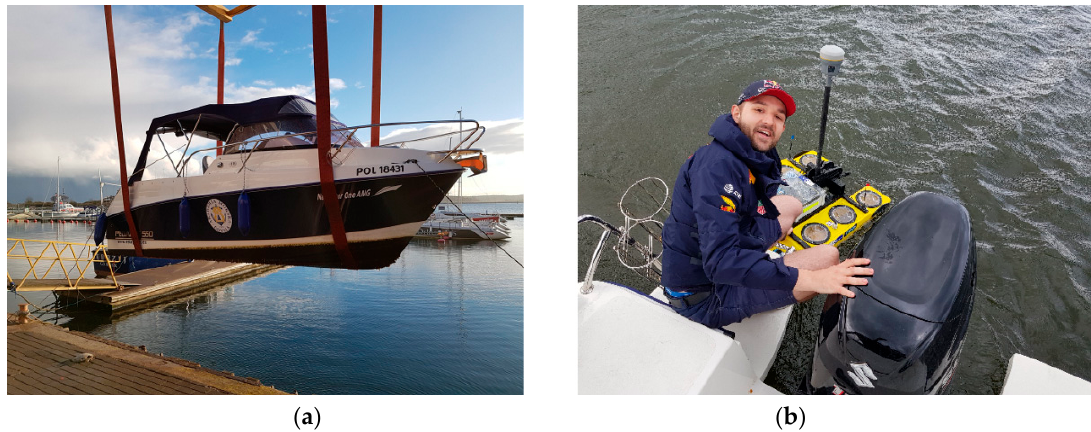
Figure 3. The hydrographic survey motorboat Navigator One AMG ( a ), an unmanned vessel during hydrographic surveys in automatic mode, the team supervising the operation of the Unmanned Surface Vehicle (USV) from the deck of the Navigator One AMG vessel ( b ).